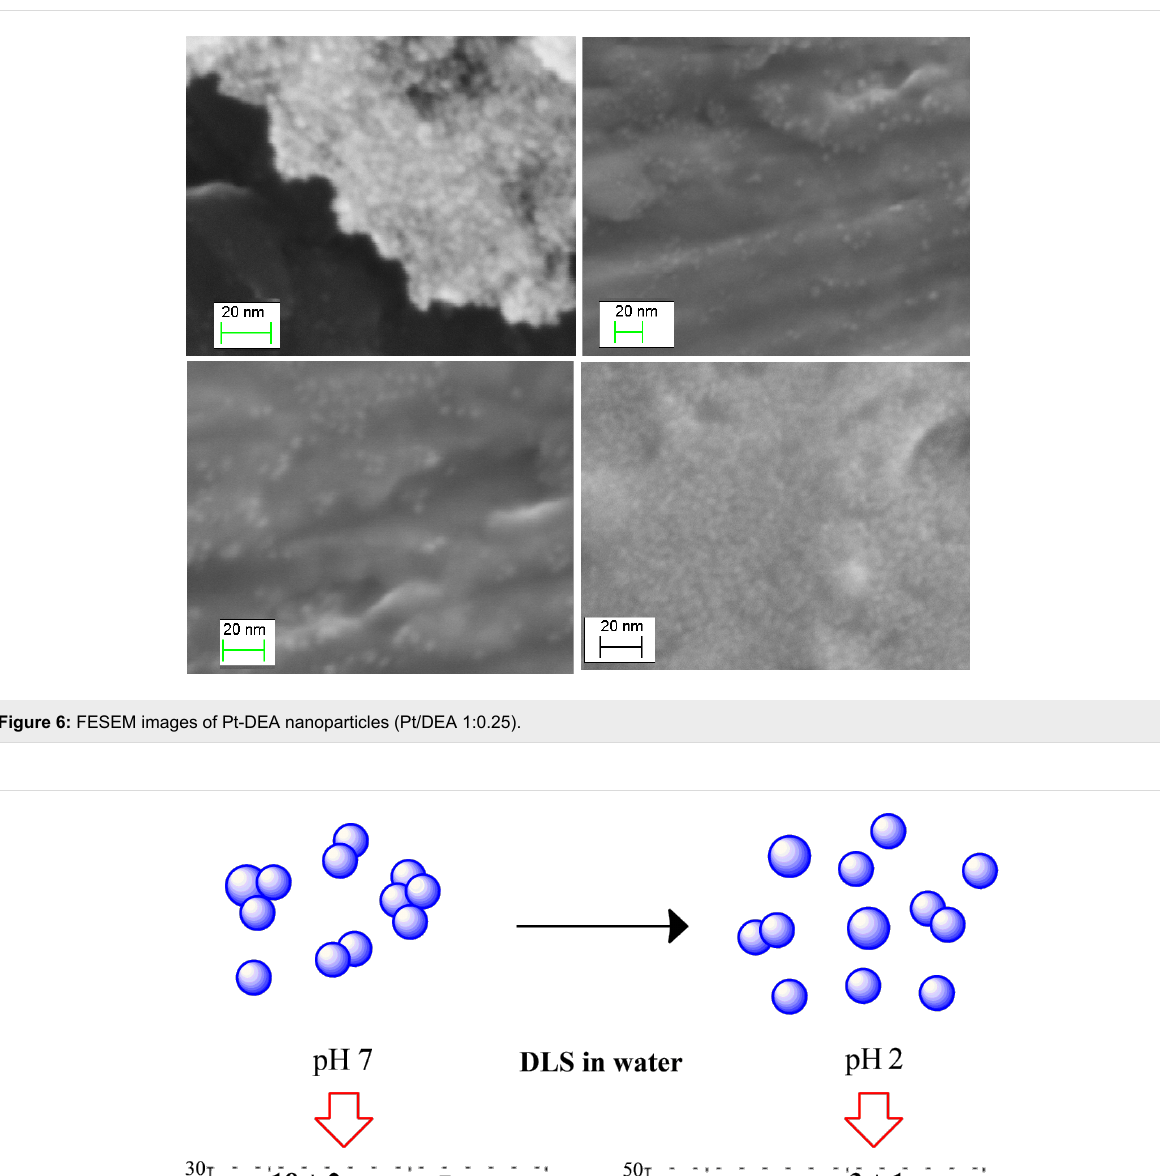
Figure 7: Sketch of the aggregation phenomenon together with DLS data of Pt-DEA nanoparticles (Pt/DEA 1:0.33) at different pH.